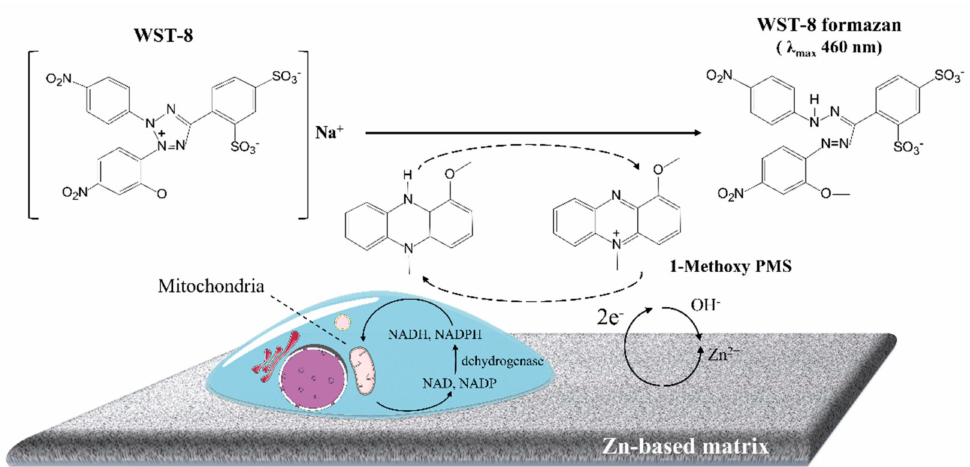
Figure 6. Schematic diagram of the principle of the metabolic activity detected by the CCK − 8 assay and the assumed formation of formazan by Zn − based